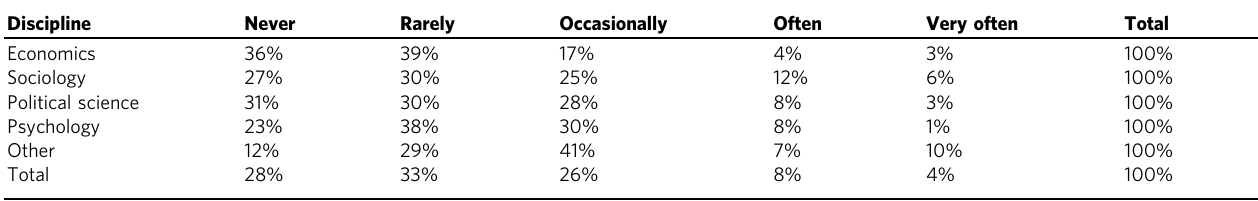
Table 3 Frequency of using fi ction in teaching by discipline.